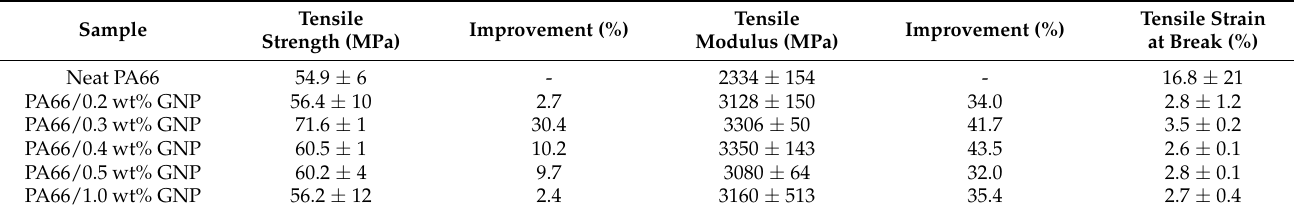
Figure 1. Tensile stress-strain curves of neat PA66 and PA66/GNP nanocomposites. Table 1. Tensile properties and improvements of neat PA66 and PA66/GNP nanocomposites.